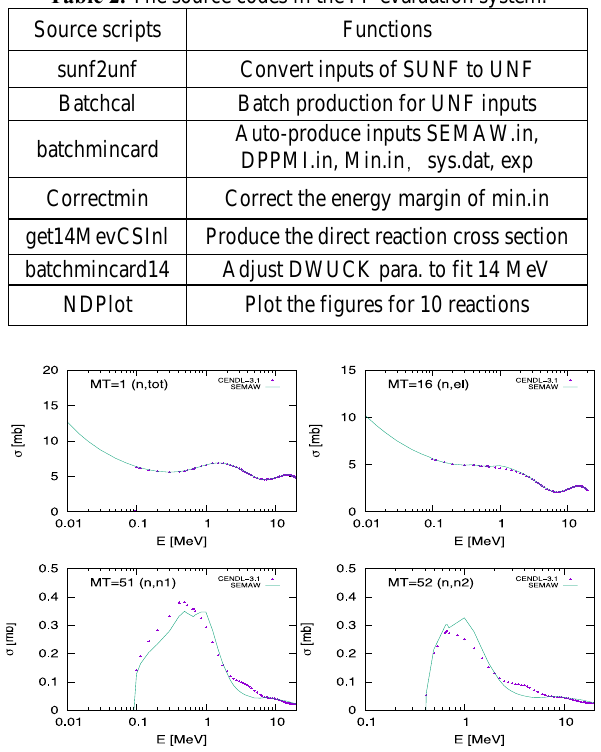
Fig. 12 . The comparison of CENDL-3.1 (points) and CENDL- 3.2 (line) for the cross sections of n+ 147 Pm reaction.